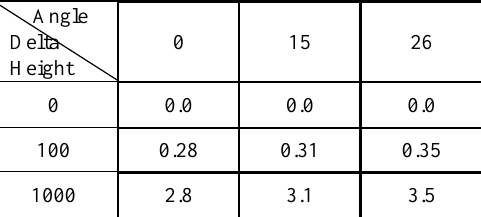
Table 1 Band to Band mis-registration (in pixels) in L4MX with different PSM steering angles and height uncertainty